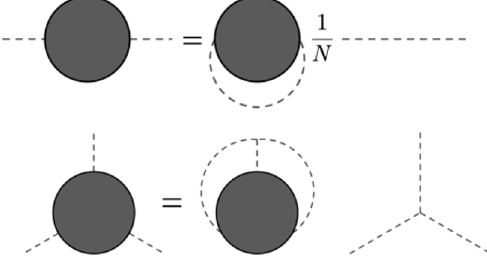
Figure 1 . Representation of the simplifying identities for the isospin structure of two- (top) and three-point (bottom) functions. Dashed edges correspond to contraction of SO(3) indices via the invariant metric, the dark blobs represent the arbitrary internal structure of the diagrams, and the explicit 3-valent vertices in the reduction of the three-point function are associated to 3 jm symbols.